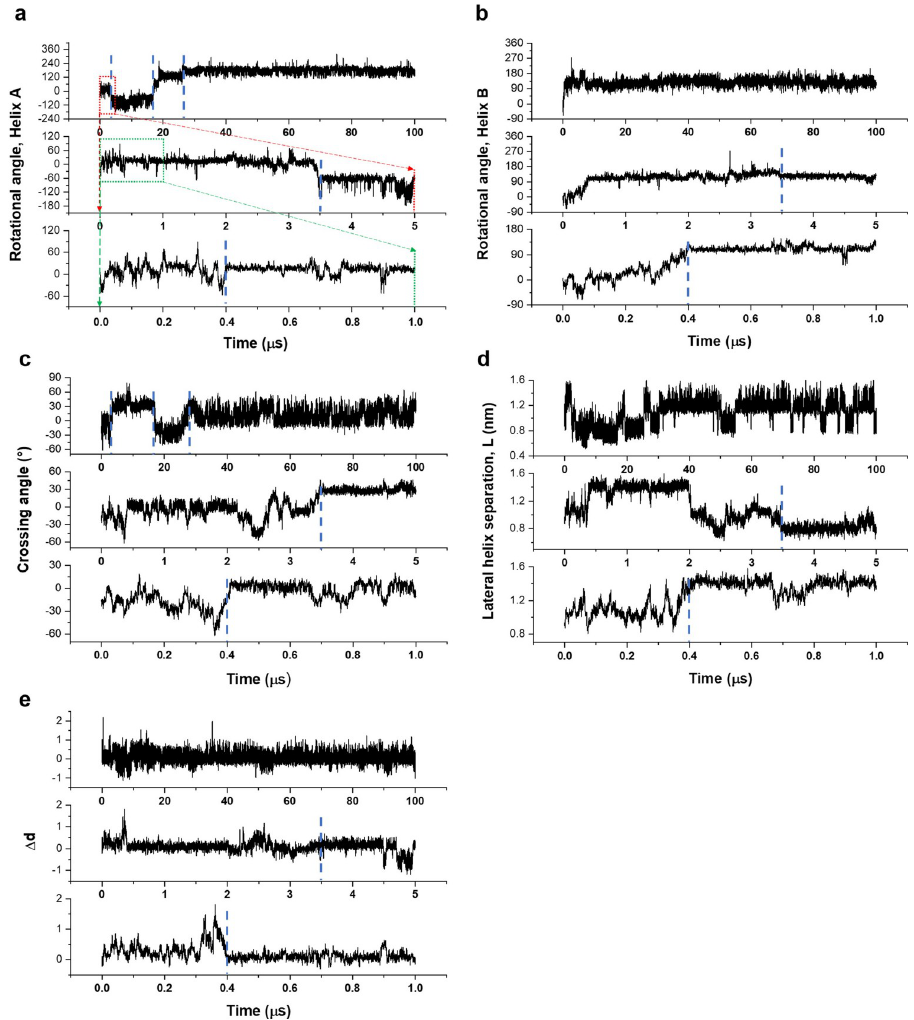
Fig 5. Analyses of collective variables of helix A and helix B in time. Time evolutions of (a) the helix A rotation angle, (b) the helix B rotation angle, (c) the crossing angle of TMD, (d) the lateral helix separation, and (e) Δ d . For visual clarity, three different time scales of 100 μ s, 5 μ s, and 1 μ s have been employed for the horizontal axes in magnifying manners. Visual guides for the magnifications are schematically drawn in (a).